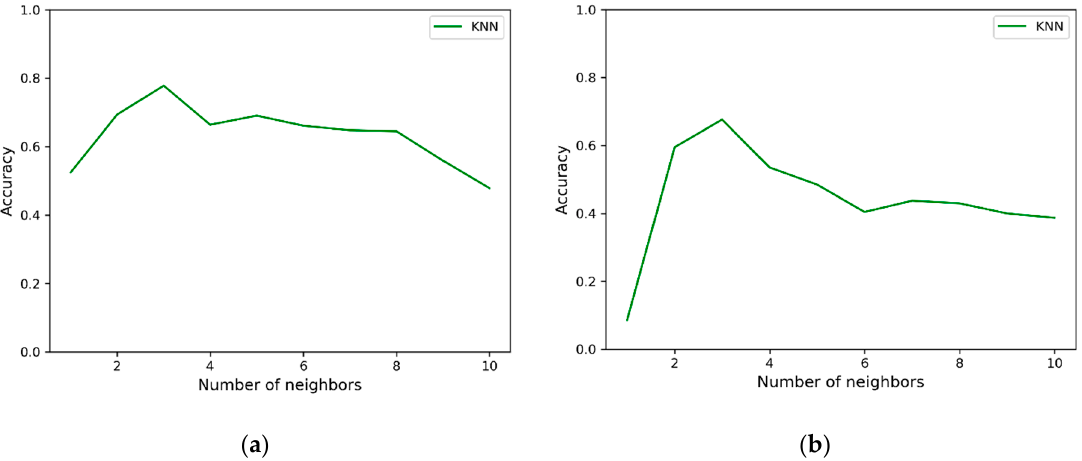
Figure 8. Accuracy of the kNN algorithm with regards to the number of nearest neighbors for ( a ) plastic viscosity and ( b ) apparent viscosity.